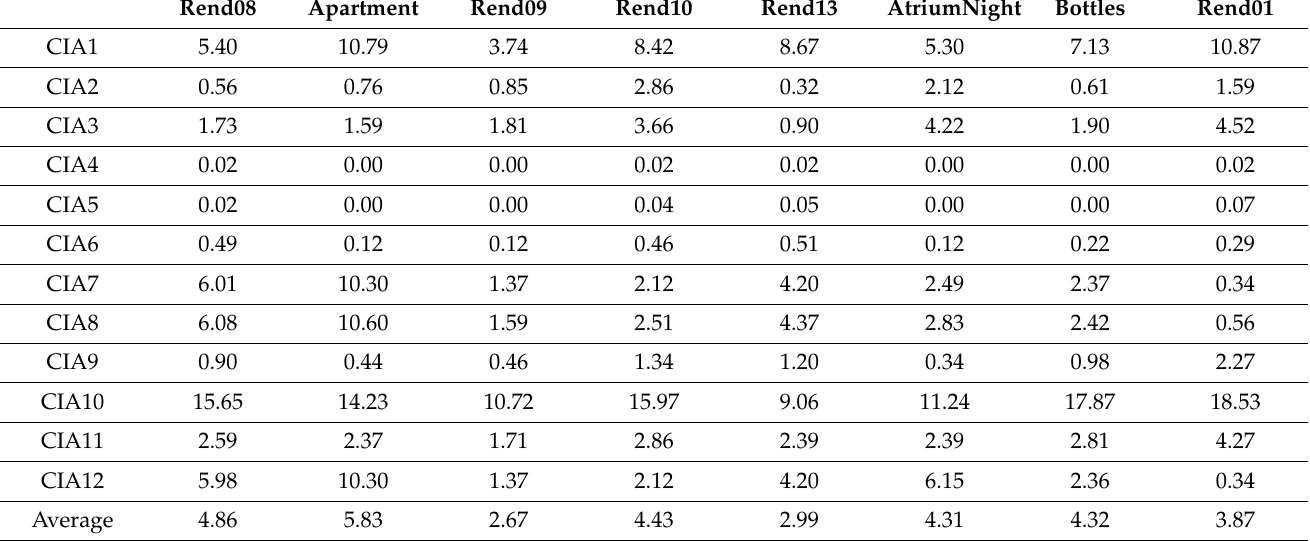
Table 4. BER s of HDR images under common image processing [%].